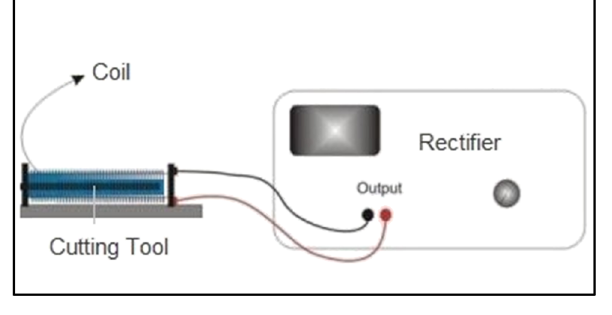
Figure 2: Magnetic fi eld setup.